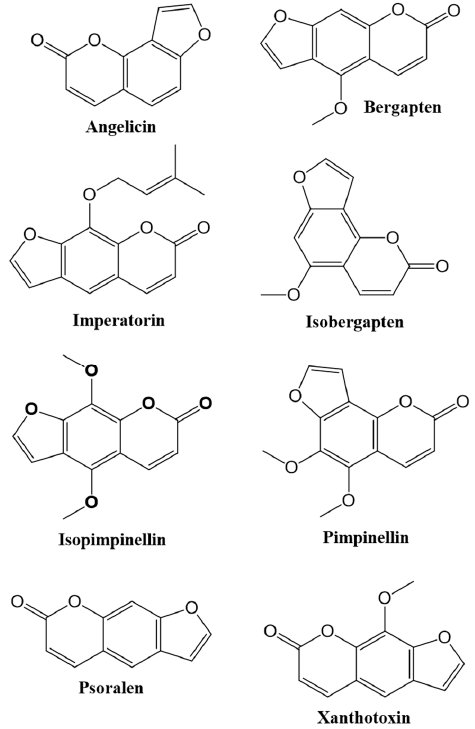
Figure 2. Chemical structures of some furanocoumarins.